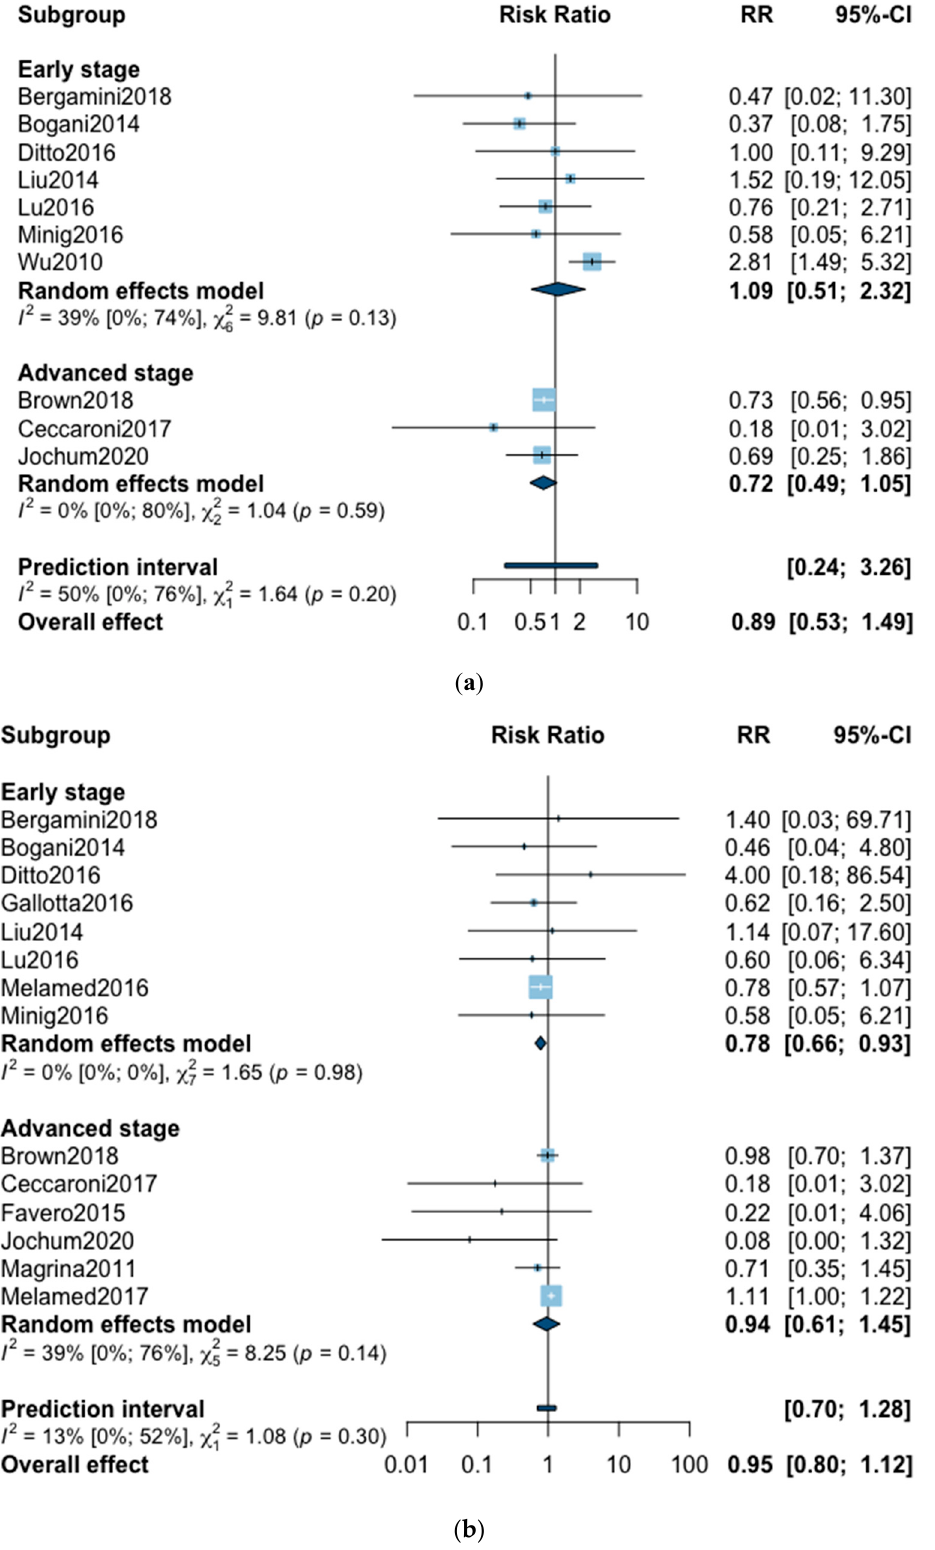
Figure 2. Forrest plot for relative risk (RR) for five ‐ year mortality ( a ) and three ‐ year mortality ( b ). Three-year mortality was reported in 14 studies (Figure 2). Three-year mortality for MIS compared with OPS was not significantly improved (RR = 0.95, 95% CI 0.80–1.12, p = 0.52). No